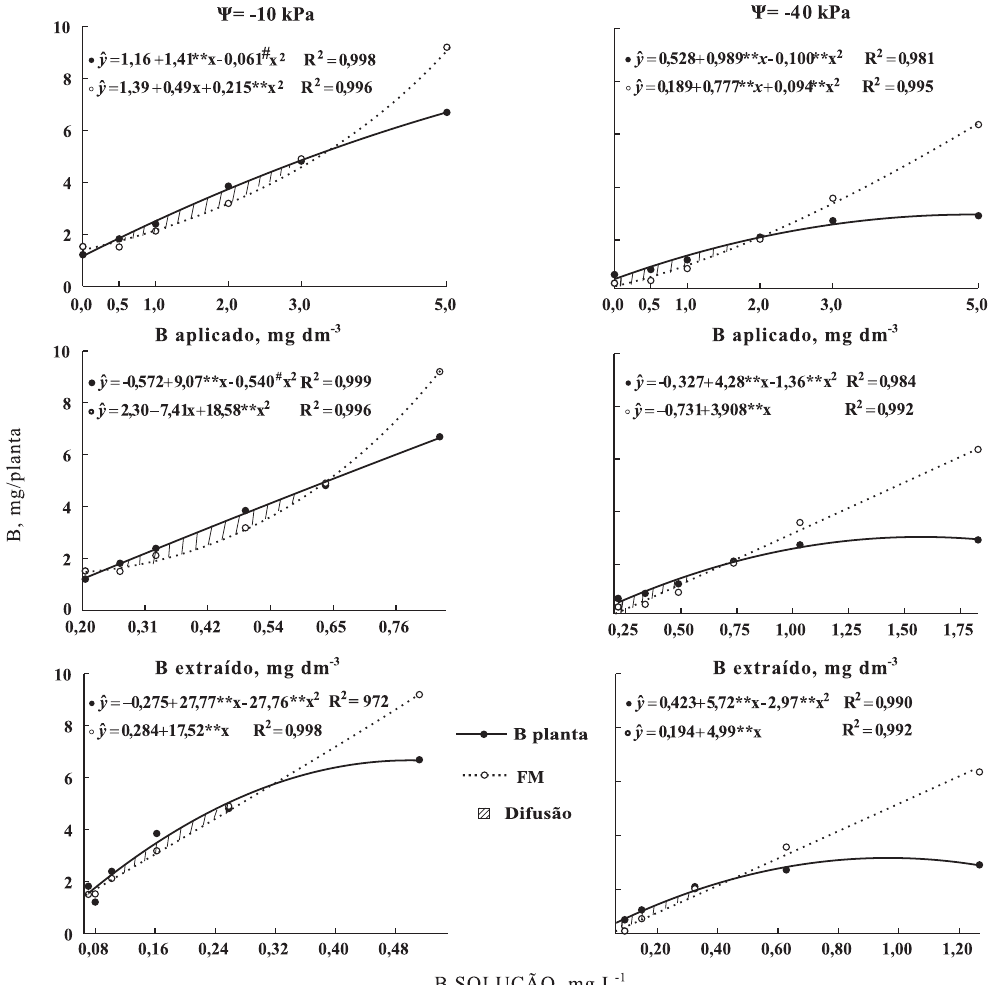
Figura 4. Conteúdo de B na planta (B planta) e B potencialmente transportado por fluxo de massa (FM) em resposta às doses de B (B aplicado), ao teor de B no solo (B extraído) e B na solução do solo (B solução), considerando o potencial de água do solo ( ΨΨΨΨΨ ). A superfície hachurada representa o B transportado por difusão. # e ** significativo a 10 e 1 %, respectivamente, pelo teste